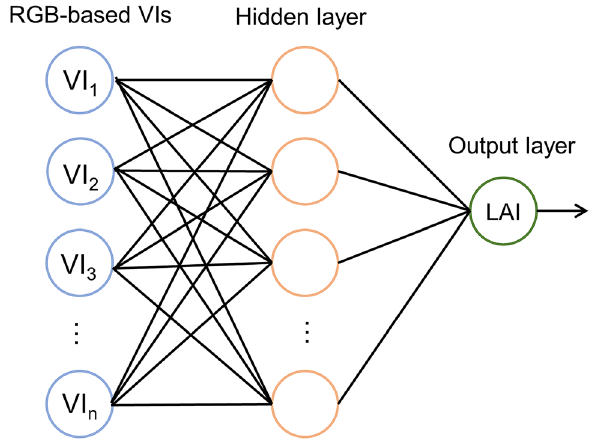
Figure 2. Three-layer BPNN model.